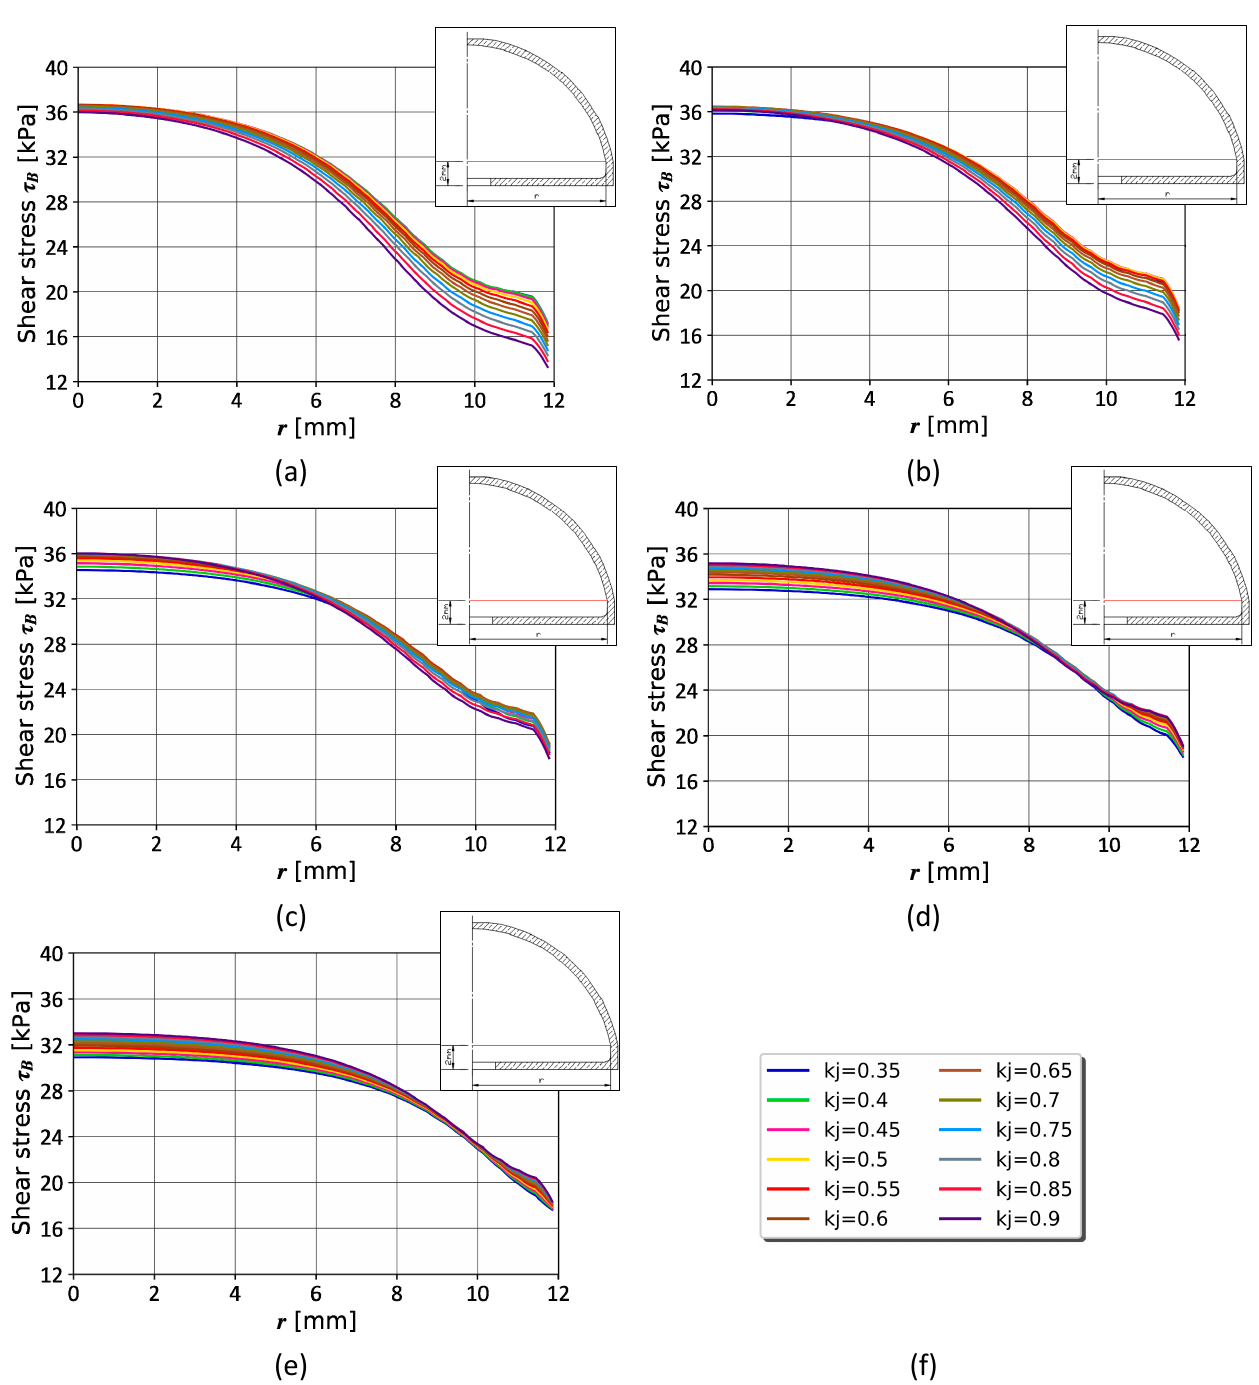
Figure 10. Shear stress distribution τ B for Instance 1 —distance z = 1 mm and thickness gm = 6 mm with different configurations of the kj factor for kpm equal to: ( a ) 0.7; ( b ) 0.75; ( c ) 0.8; ( d ) 0.85; ( e ) 0.9; ( f ) legend.